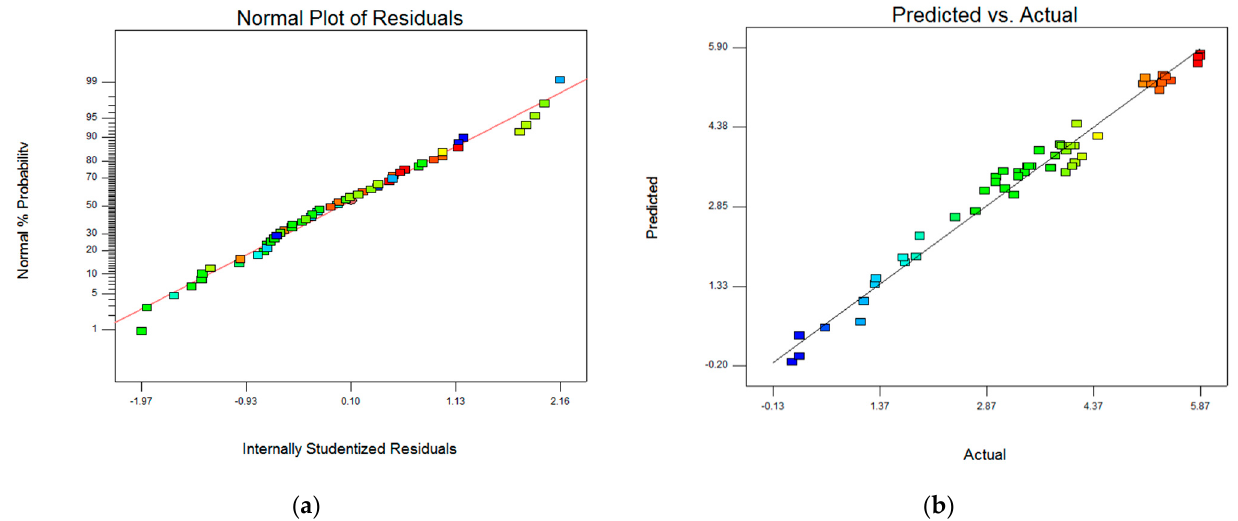
Figure 1. ( a ) Normal plot of residuals for surface finish. ( b ) Predicted vs. actual plot for surface finish.